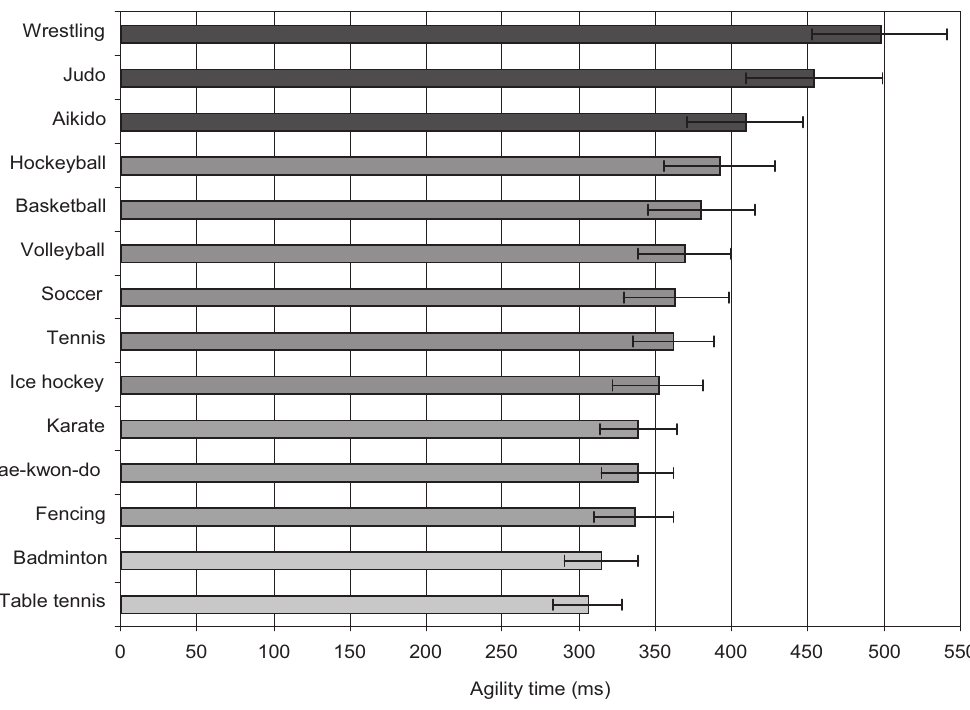
Figure 2. Agility time in groups of athletes of different sport specializations